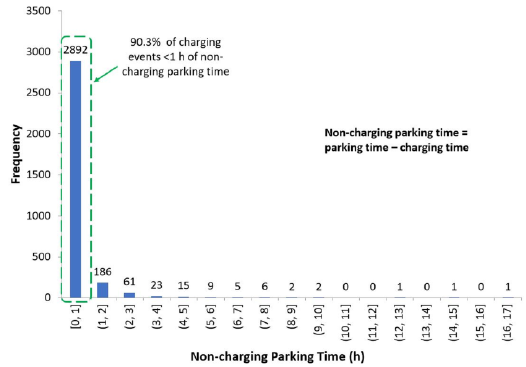
Figure 2. Histogram of the non-charging parking time in each charging event.